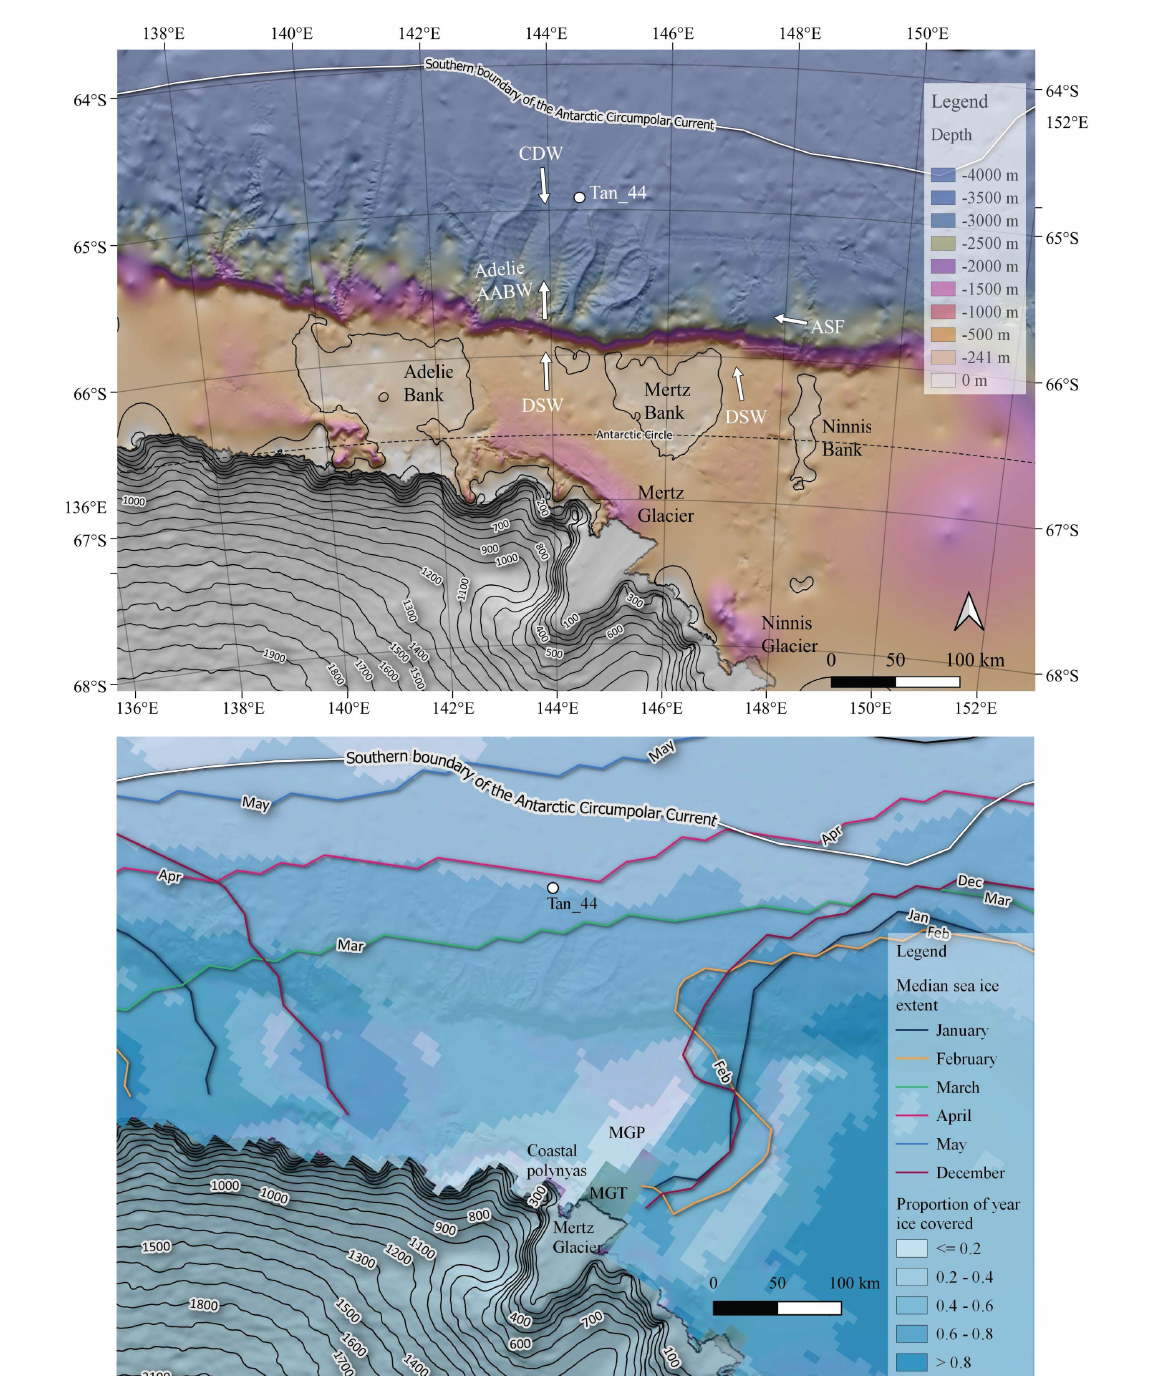
Figure 1. Top panel: location of core Tan_44 with respect to the regional bathymetry (Arndt et al., 2013), oceanography (Orsi et al., 1995; Williams et al., 2010) and cryosphere (Helm et al., 2014). The Mertz and Ninnis glaciers (Helm et al., 2014) are dominant glacial features in the region. Adélie and Mertz banks are prominent geomorphological features on the continental shelf, while deep channels are prominent on the continental slope. Tan_44 is located within the WEGA channel. The site is influenced at present by Adélie-sourced Antarctic Bottom Water (Adelie AABW), Circumpolar Deep Water (CDW) and-along slope flow of Antarctic Slope Front (ASF; Williams et al., 2010). Bottom panel: modern seasonal sea ice cover: the darkest blue shows regions covered by ice for more than 80% of the year, while the lightest blues indicate areas covered by ice less than 20% of the year (Spreen et al., 2008), showing the Mertz Glacier polynya (MGP) and the coastal polynyas, where the main proportion of Adélie DSW forms, west of the Mertz Glacier Tongue (MGT; Williams et al., 2010). The figure also shows that the core site is covered by sea ice from April to November each year (coloured lines; Fetterer et al., 2017).